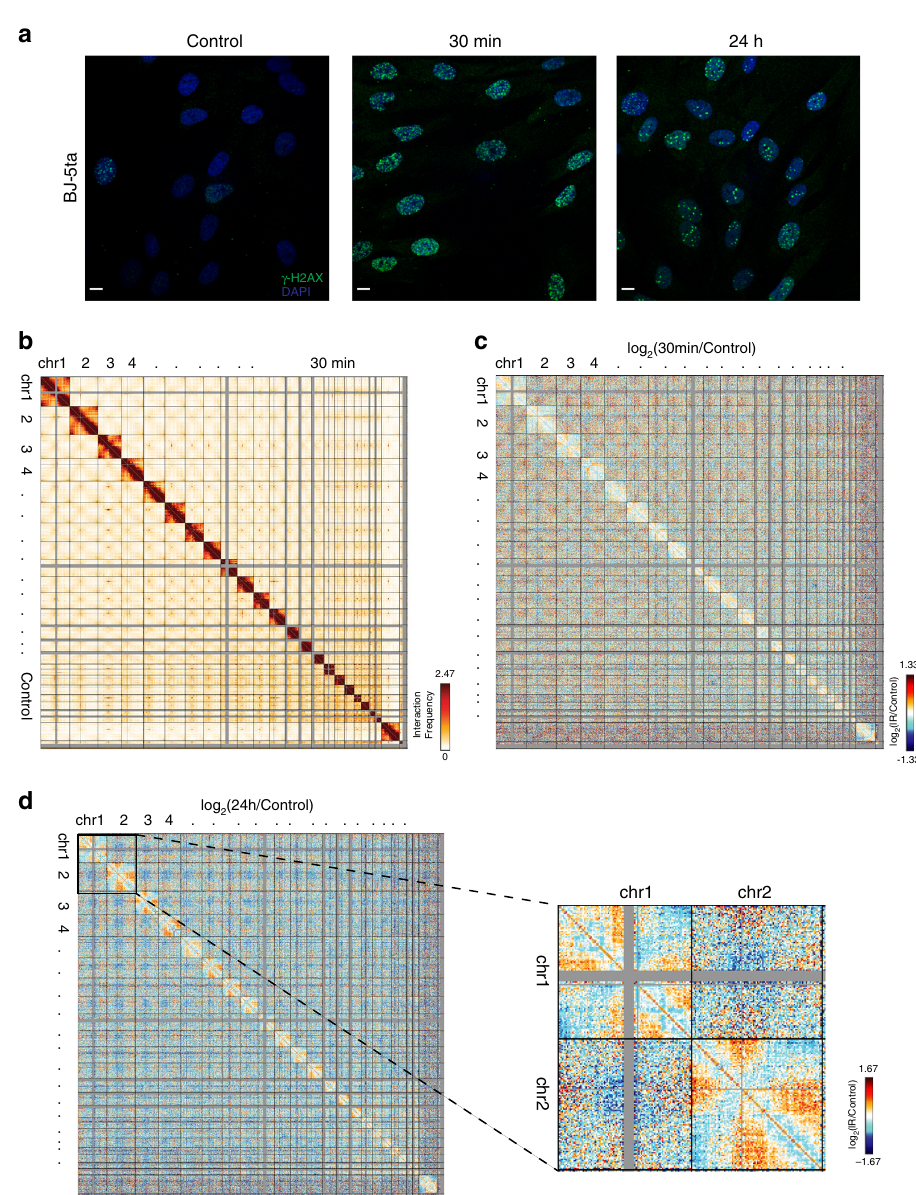
Fig. 1 Subtle changes to genome organization in IR exposed BJ-5ta skin fi broblasts. a BJ-5ta stained with γ H2AX (green) and DAPI (blue) before (Control) or after (30 min and 24 h) exposure to 5 Gy X-rays. Scale bar: 10 μ m. b Genome-wide contact heatmap for BJ-5ta nonirradiated (lower left) or 30 min after IR (upper right) in 2.5 Mb bins. c log2(30 min post-IR/Control) contact heatmap in 2.5 Mb bins. d log2(24 h post-IR/Control) contact heatmap in 2.5 Mb bins. Inset reveals loss of interactions between chromosome arms and decrease in telomere-telomere interactions on chromosomes 1 and